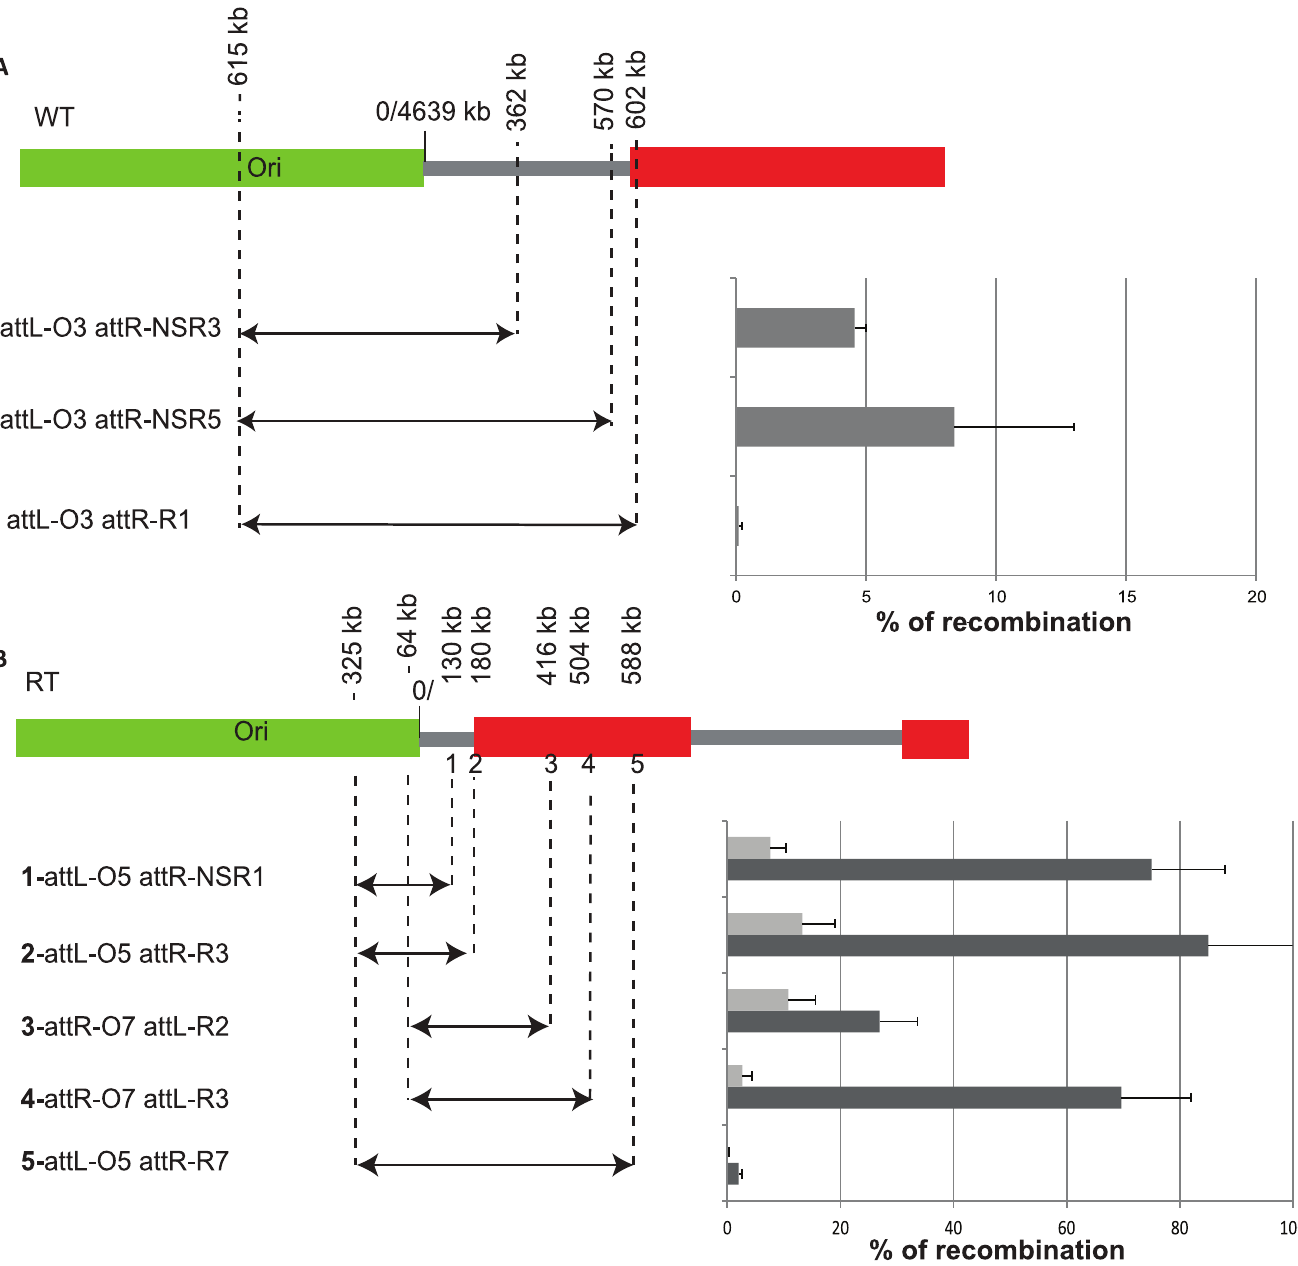
Fig 3. The interaction limit of the Ori MD. Graphical representation of the Ori MD (greenbox), NSR region(gray line)and Right MD (red box). Coordinates of the attR/L sequences are indicatedin fonction of their distancefrom the zero pb referenceof the MG1655 genome for both configuration WT and RT. Percentages of recombination between attL and attR obtainedafter inductionof 20’ at 36˚C or 10’ at 37˚C are shown.The histograms correspond to an averageof at least 3 independent experiments with